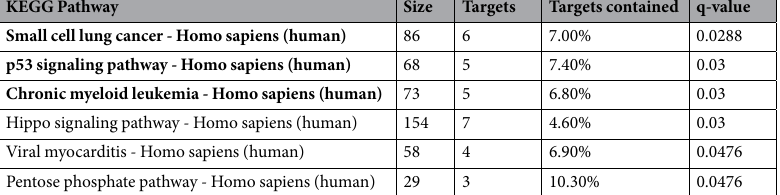
Table 3. Associated KEGG pathways from positively correlated target gene expressions. Cancer related pathways are marked in bold.